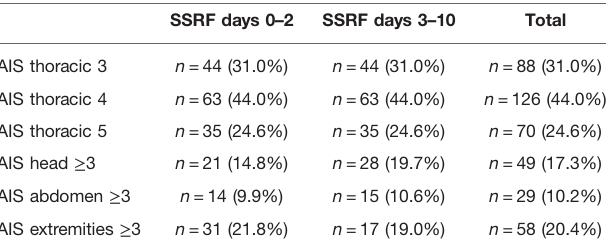
FIGURE 1 | Selection process of the patient collective before matching. D, Germany; A, Austria; CH, Switzerland; AIS, Abbreviated Injury Scale; SSRF, Surgical Stabilization of Rib Fractures. TABLE 1 | Distribution of AIS.